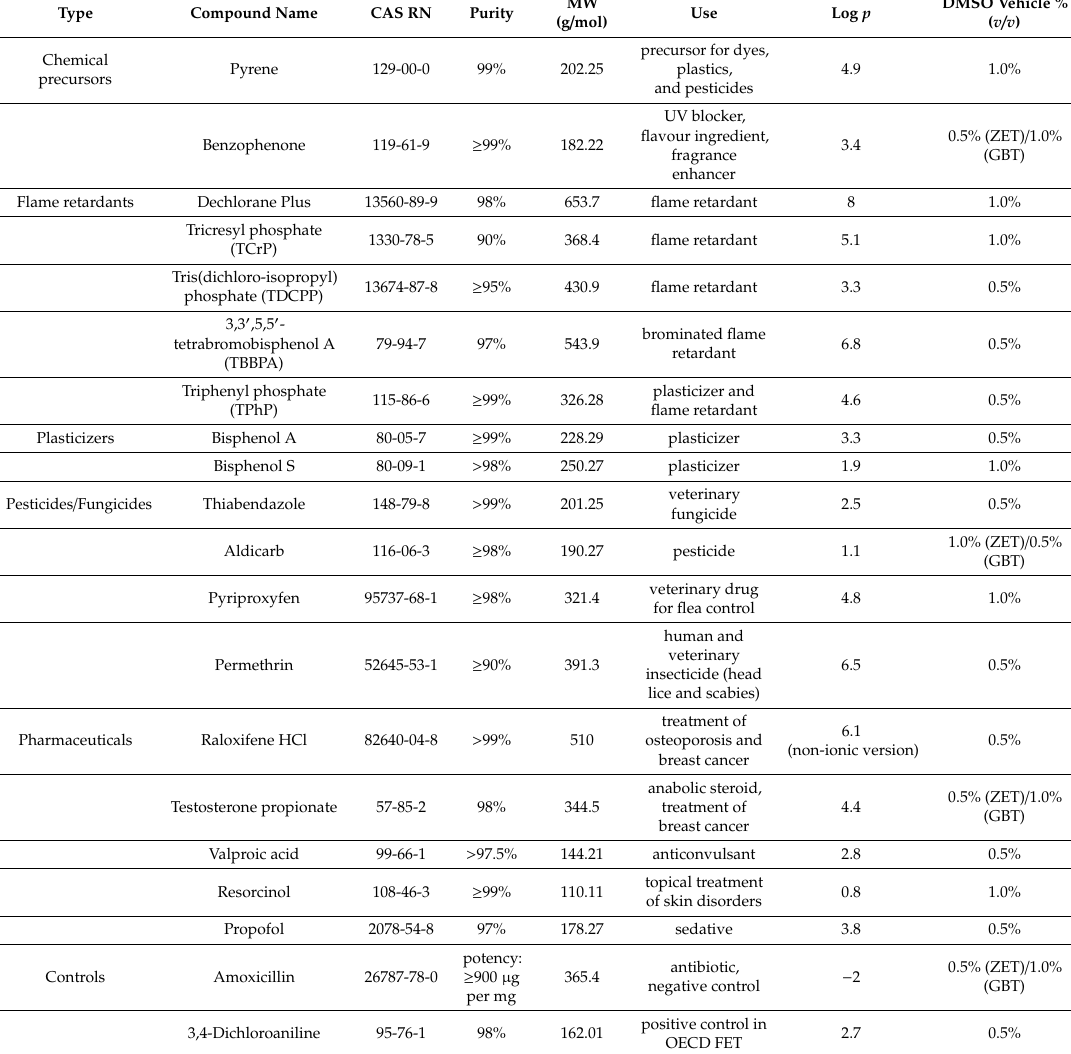
Table 1. Groupings of chemicals tested in this study. Chemicals are grouped by use and span a wide range of molecular weights and Log p values. All compounds were tested in the presence of dimethyl sulfoxide (DMSO) as a carrier with the percentage of DMSO used for each compound